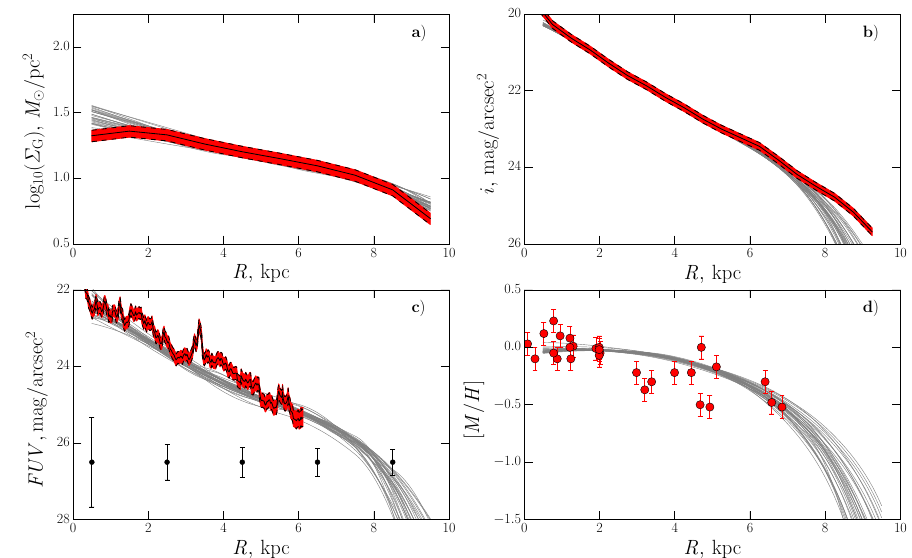
Fig. 3. Same as Fig. 2, but only models with r.m.s. deviations from the observed radial profiles (gas surface density and i passband) smaller than 10 % and in the radial distance range 2–7 kpc are shown.